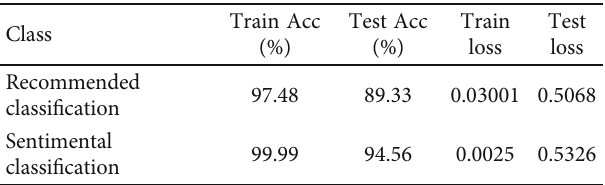
Table 7: Deep sentiment classi fi er on average training and